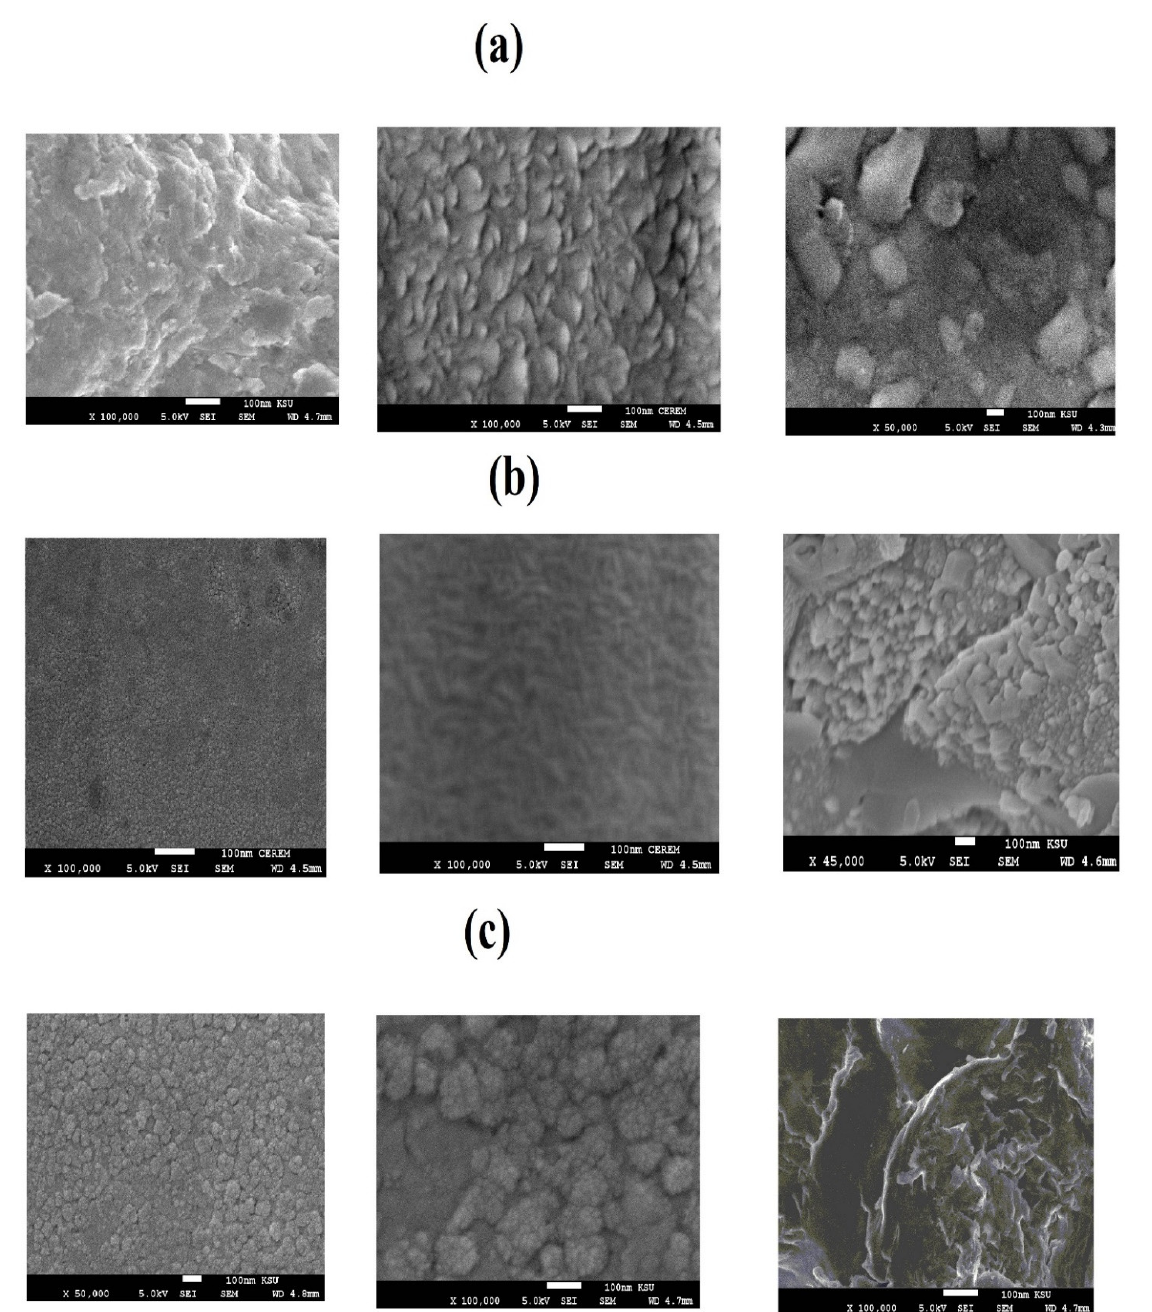
Figure 10. SEM micrographs of fractured cured DGEB/ PA films using different wt % from left to right 1, 3 and 10 wt % of TiO 2 NPs capped with ( a ) EOA, ( b ) ELOA and ( c ) ELNA.